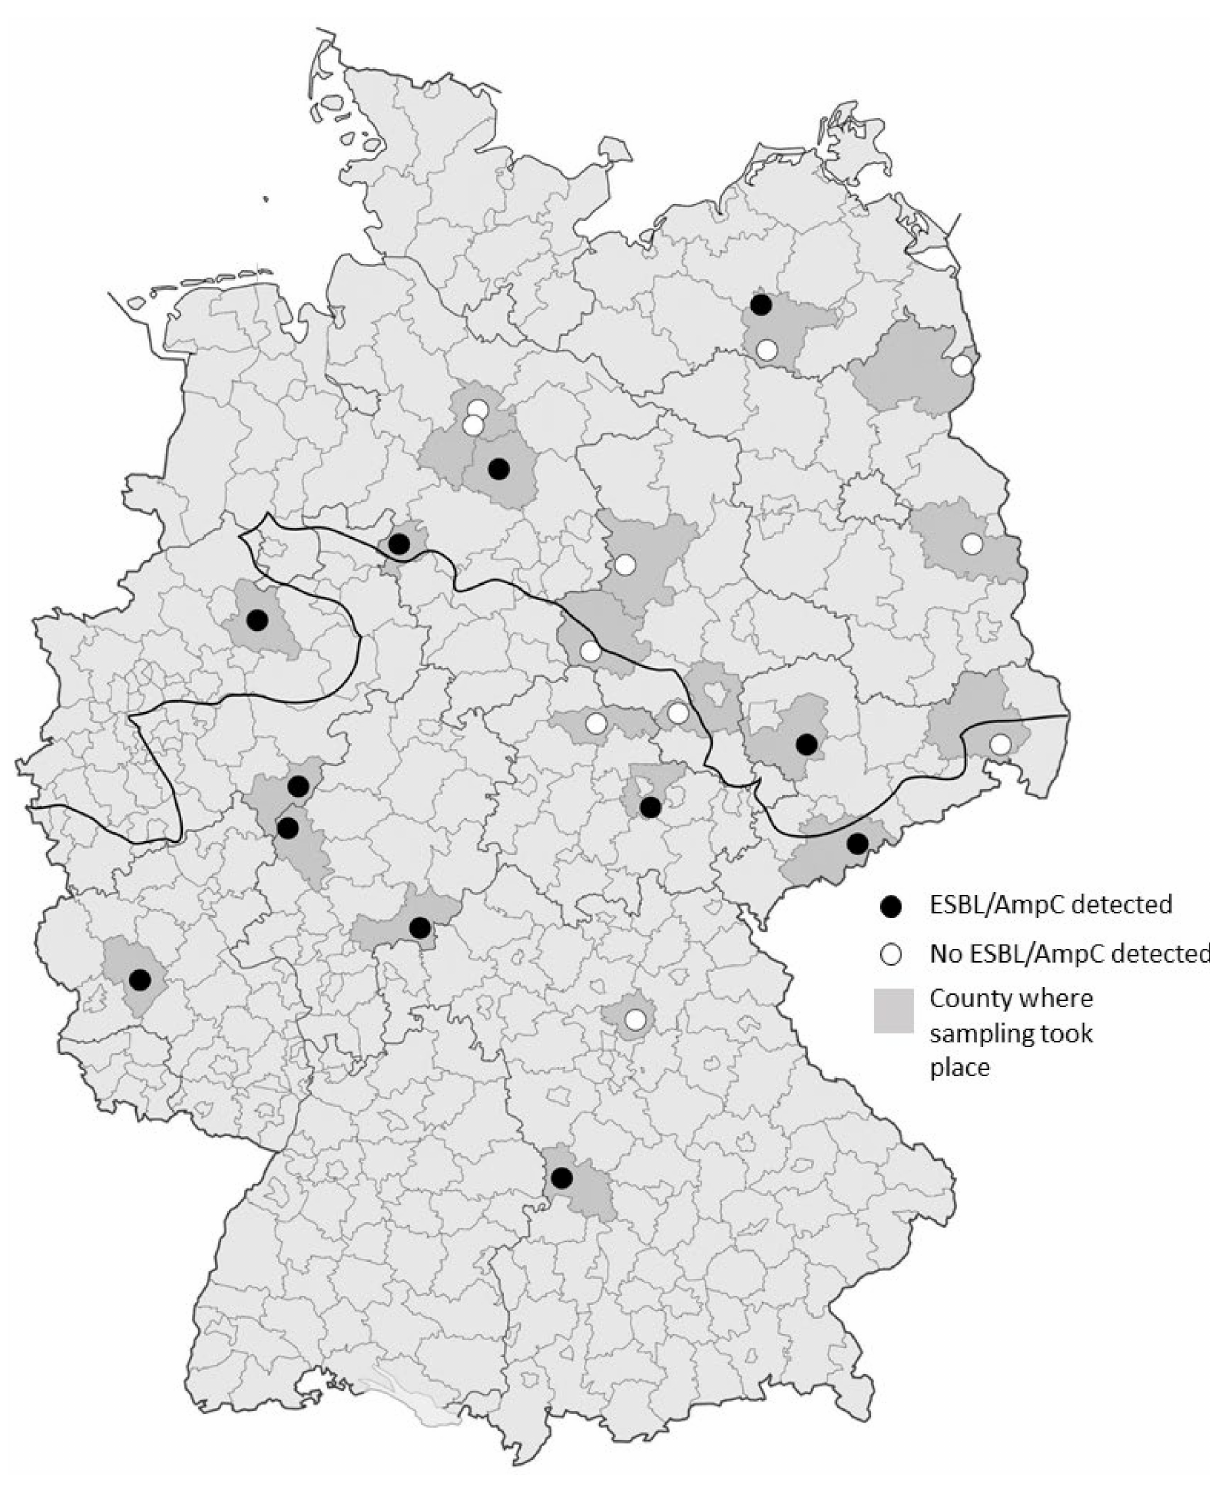
Figure 1. Geographic distribution of sampled hunting locations within Germany. Counties, where sampling took place are shaded in darker grey and the individual hunting locations are represented by circles. Black circles represent locations where ESBL/AmpC-producing E. coli were detected, white circles represent locations where all samples tested negative. The fat black line indicates the division between the North German Lowlands and the region of Middle and Southern Germany, including higher